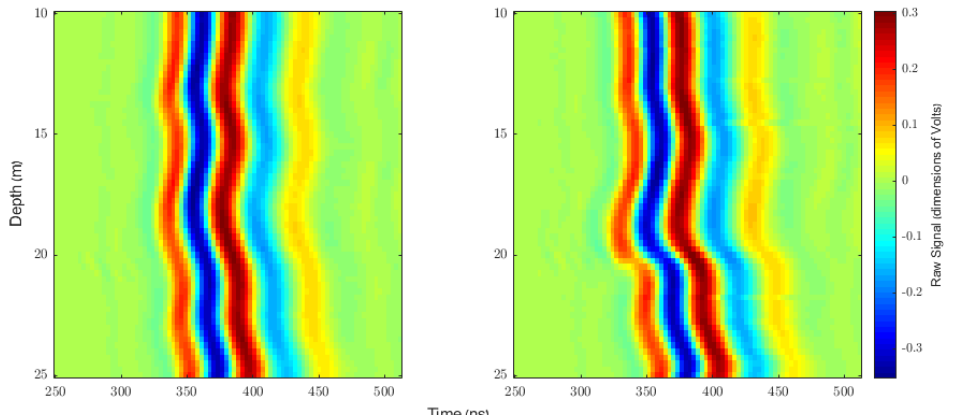
Figure 6. Two real measured ZOP profiles taken from adjacent pairs of boreholes at the same test site characterized by stratified sedimentary rock. In each profile, the transmitter and receiver boreholes were seven meters apart. The signals measured at each depth were normalized to have unit energy. The boreholes used to measure the profile shown on the left do not bracket any cavities, while the boreholes used to measure the profile shown on the right bracket a cavity located at around 19 or 20 m below the surface. The signals were cropped in order to better show the most relevant portions.